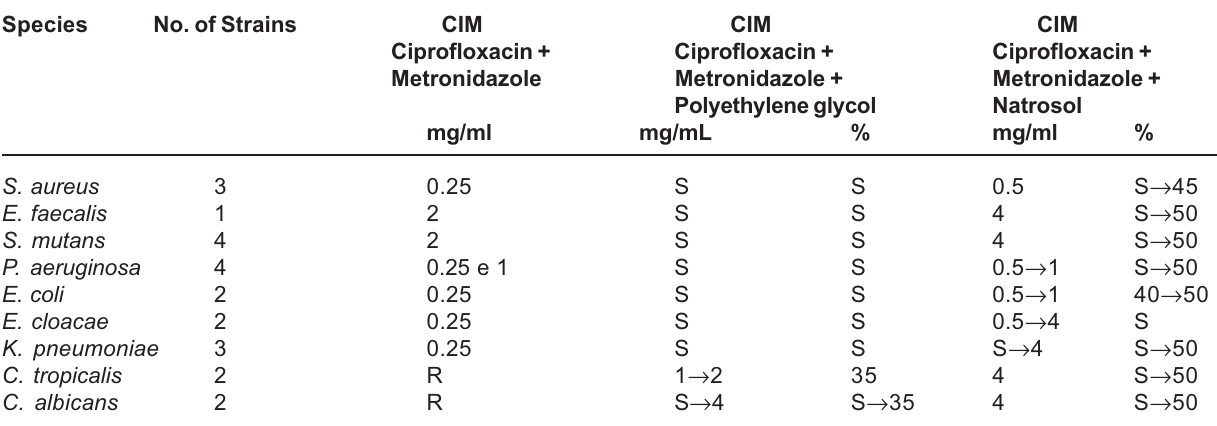
R = resistant at the highest concentration tested (16 µ g/ml or 50%); S = sensitive at the lowest concentration tested (0.25 µ g/ ml or 25%); → interval of concentration of the tested products.